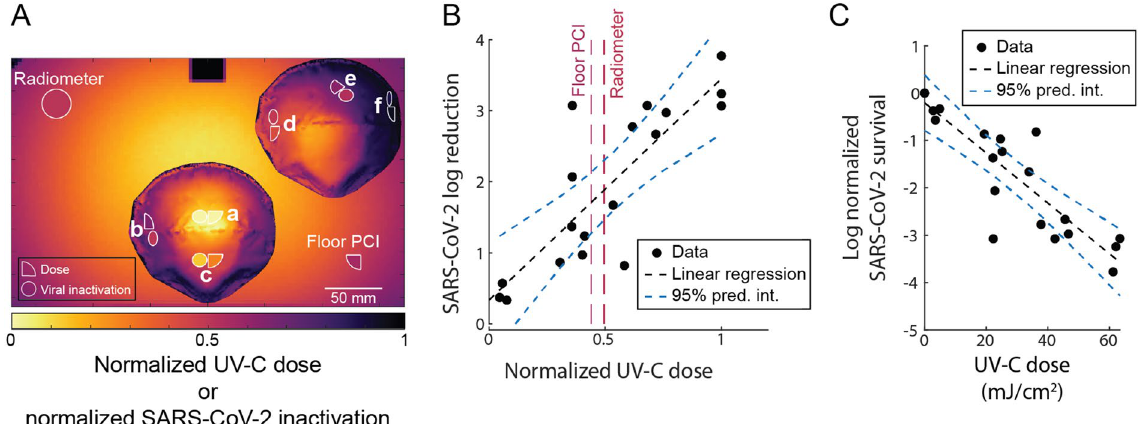
Figure 5. Paired on-N95 measurements of UV-C dose and SARS-CoV-2 inactivation show correlated, several-fold variation in dose and inactivation across one decontamination chamber. ( A ) Average normalized UV-C dose (quarter-circles on-N95) and SARS-CoV-2 inactivation (circles on-N95) at measured locations on front and corner N95, colored by the normalized value. UV-C doses at two corners of the chamber floor were measured by a radiometer (large circle) and PCI (quarter-circle). Values are normalized to measurements at the apex of the front N95. Surrounding heatmap shows simulated UV-C dose. ( B ) SARS-CoV-2 inactivation on N95 facepieces is proportional to UV-C dose received. Selected locations on two N95 facepieces in the Spectronics XL-1000 UV-C chamber receive a 17.4 ± 5.0-fold difference in UV-C dose, which yields an 8.2 ± 1.4- fold difference in SARS-CoV-2 log reduction. Vertical dashed lines indicate the normalized UV-C dose measured by either a PCI or radiometer at monitoring sites in the chamber corners and are colored according to the heatmap in ( A ). Black dashed line indicates linear least squares regression on data (y = mx + b; m = 3.114 (2.038, 4.19), b = 0.3342 (− 0.3062, 0.9766); numbers in parentheses represent a 95% confidence interval on the fit parameters). Pearson correlation coefficient r = 0.8376; p-value = 1.4428 × 10 –5 . ( C ) Normalized on-N95 SARS- CoV-2 dose–response curve for 2 N95 facepieces. Datapoints represent log 10 (normalized SARS-CoV-2 survival), where normalized SARS-CoV-2 survival is calculated as TCID 50 /mL divided by the time-matched negative control TCID 50 /mL. Black dashed line indicates linear regression on data (y = mx + b; m = − 0.0531 (− 0.06653, − 0.03961), b = − 0.2045 (− 0.6663, 0.2574). Pearson correlation coefficient r = − 0.8842; p-value = 1.0526 × 10 –7 . Based on linear regression, the estimated D 90 dose is between 18.83 and 19.03 mJ/cm 2 , depending on whether the y-intercept value is ignored or considered, respectively. In both ( B ) and ( C ), blue dashed lines denote simultaneous functional 95% prediction interval for the linear least squares regression, which indicates where the true linear regression line lies, with 95%